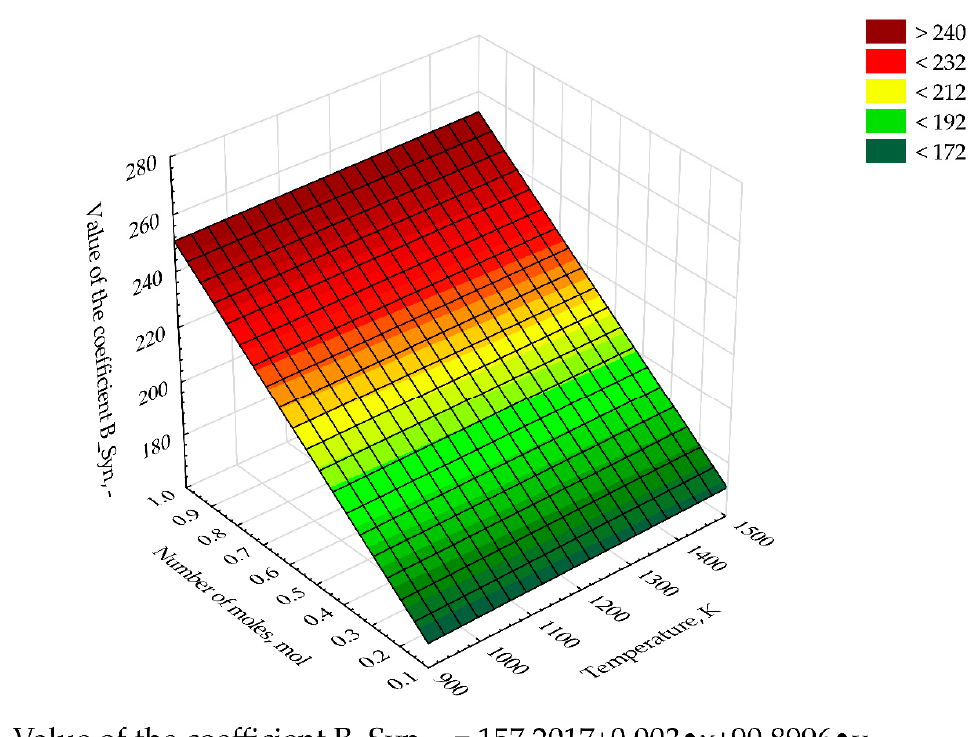
Figure 14. Value of the syngas compression ratio as a function of the number of moles of the gasification agent (x) and the temperature (y) of the gasification process using air.